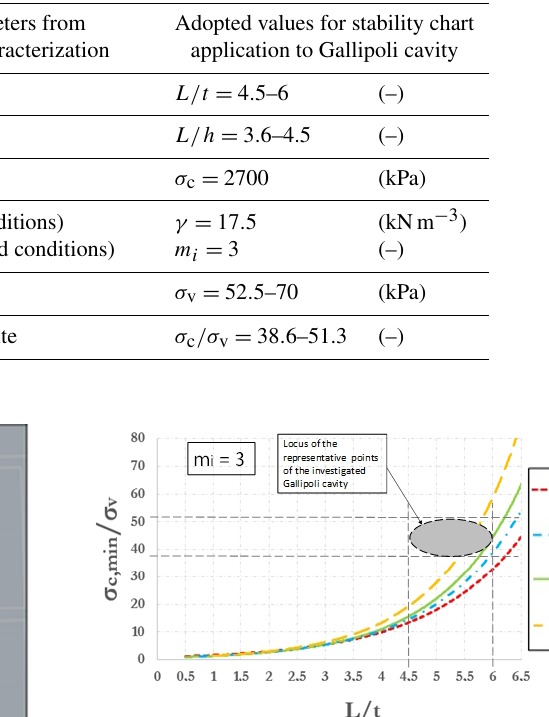
Table 4. Geometrical and mechanical parameters and adopted values for stability chart application to the Gallipoli underground quarry.